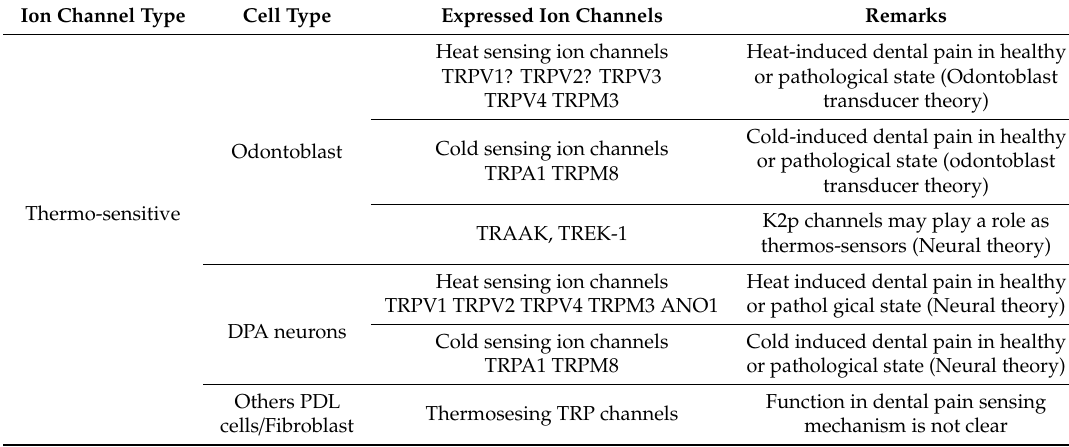
Table 1. Tabular summary of ion channels expressed in dental pain sensory system and their